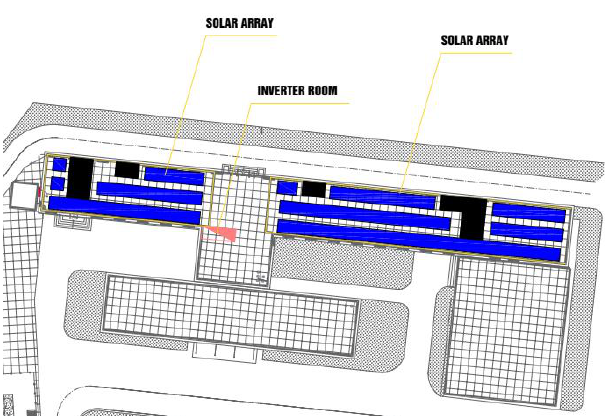
Figure 6. Arrangement of solar panel on the roof of the research building